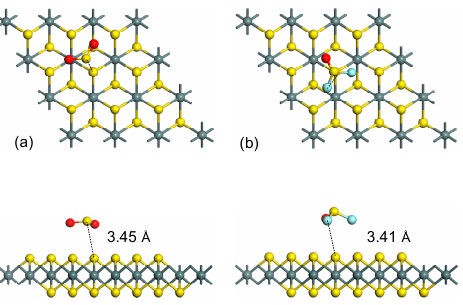
Figure 10. Structural model. ( a ) SO 2 molecular structure; ( b ) SOF 2 molecular structure; ( c ) SnS 2 surface structure.